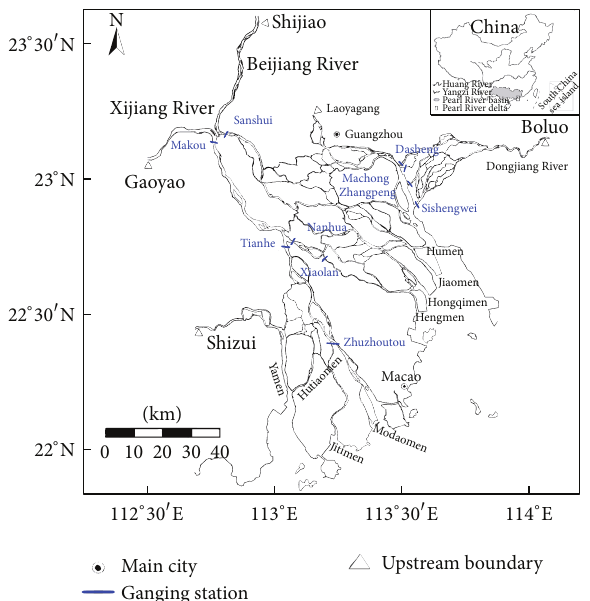
Figure 4: Map of the Pear River networks and sampling